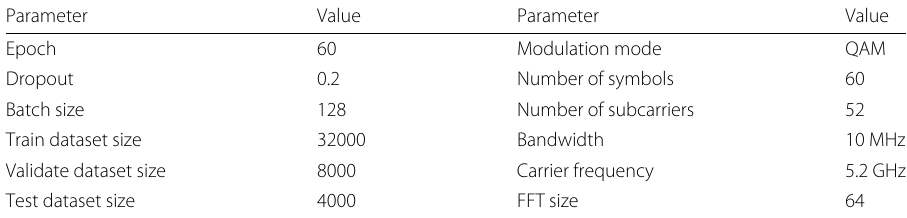
Table 2 The parameters of